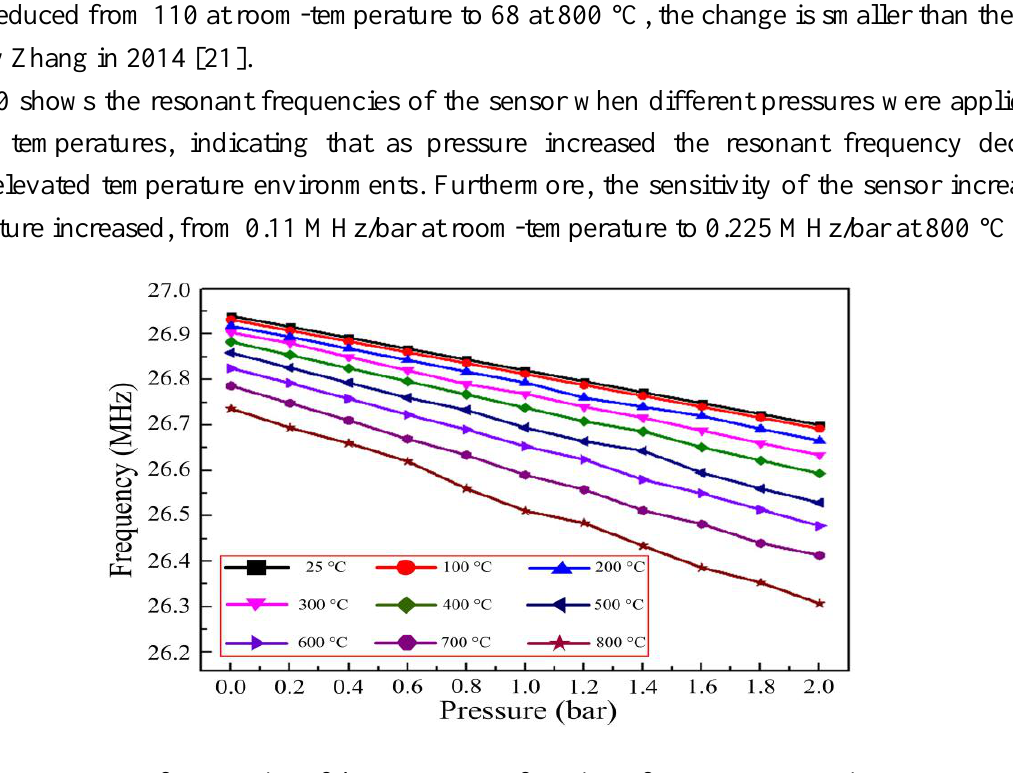
Figure 10. Resonant frequencies of the sensor as a function of pressure at varying temperatures.